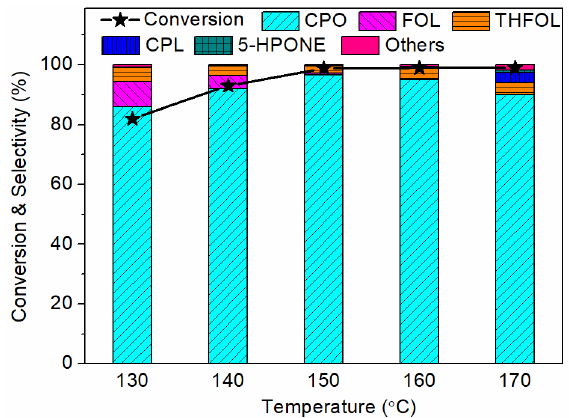
Figure 8. Effect of reaction temperature on conversion and product selectivity in hydrogenative ring-rearrangement of FAL over Pd/UiO-66-NO 2 - 7 . Reaction conditions: catalyst (5.0 mg), FAL (100.0 mg), H 2 O (9.9 g), 1.0 MPa H 2 pressure, 5 h.